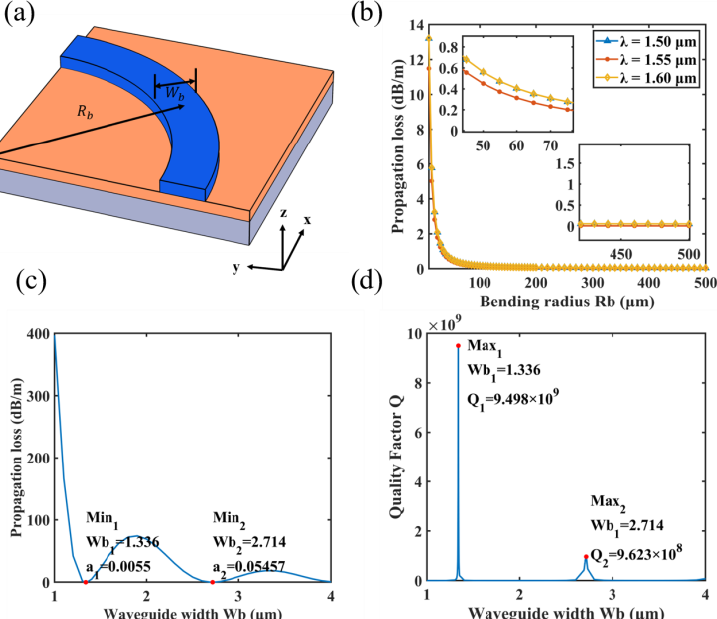
Figure 7. Simulation of the optical properties of the BIC structure under the bent waveguide: ( a ) illustration of the bent waveguide structure supporting a BIC mode, where Wb and Rb denote the width and radius of the bent waveguide, respectively; ( b ) the variation curve of propagation loss with bending radius Rb at different wavelengths in the bent waveguide shown in ( a ) is simulated when the waveguide width is 1.336 μm ; ( c ) the propagation loss curve of the bent waveguide at 1.55 μm wavelength as a function of waveguide width Wb when the bending radius Rb is 500 μm ; ( d ) the quality factor of the bent waveguide as a function of waveguide width Wb at the wavelength of 1.55 μm when the bending radius Rb is 500 μm.